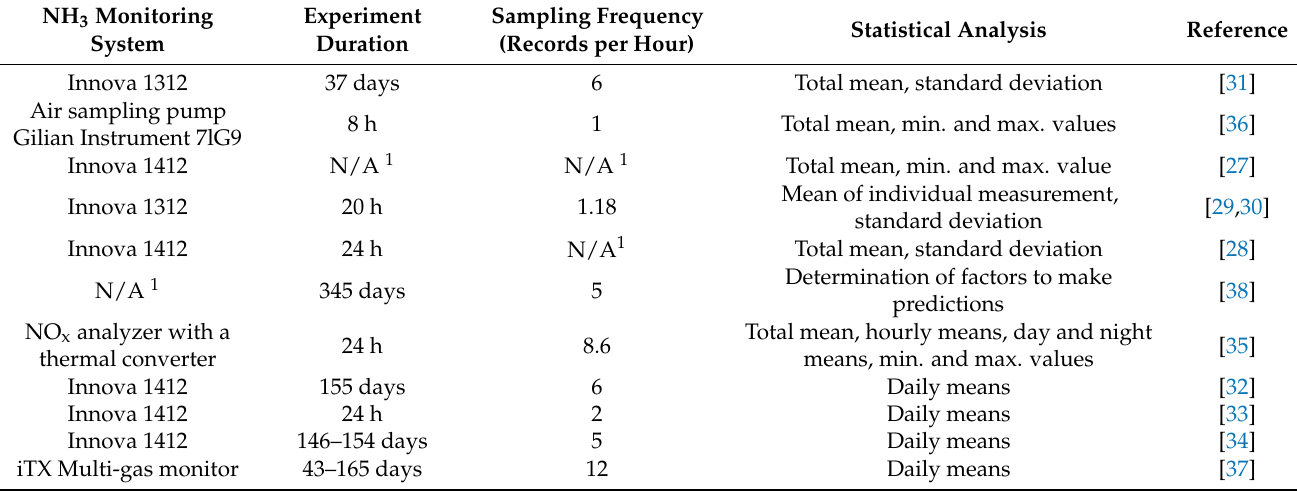
Table 1. Recent studies on the measurement of NH 3 emissions in pig farms and their